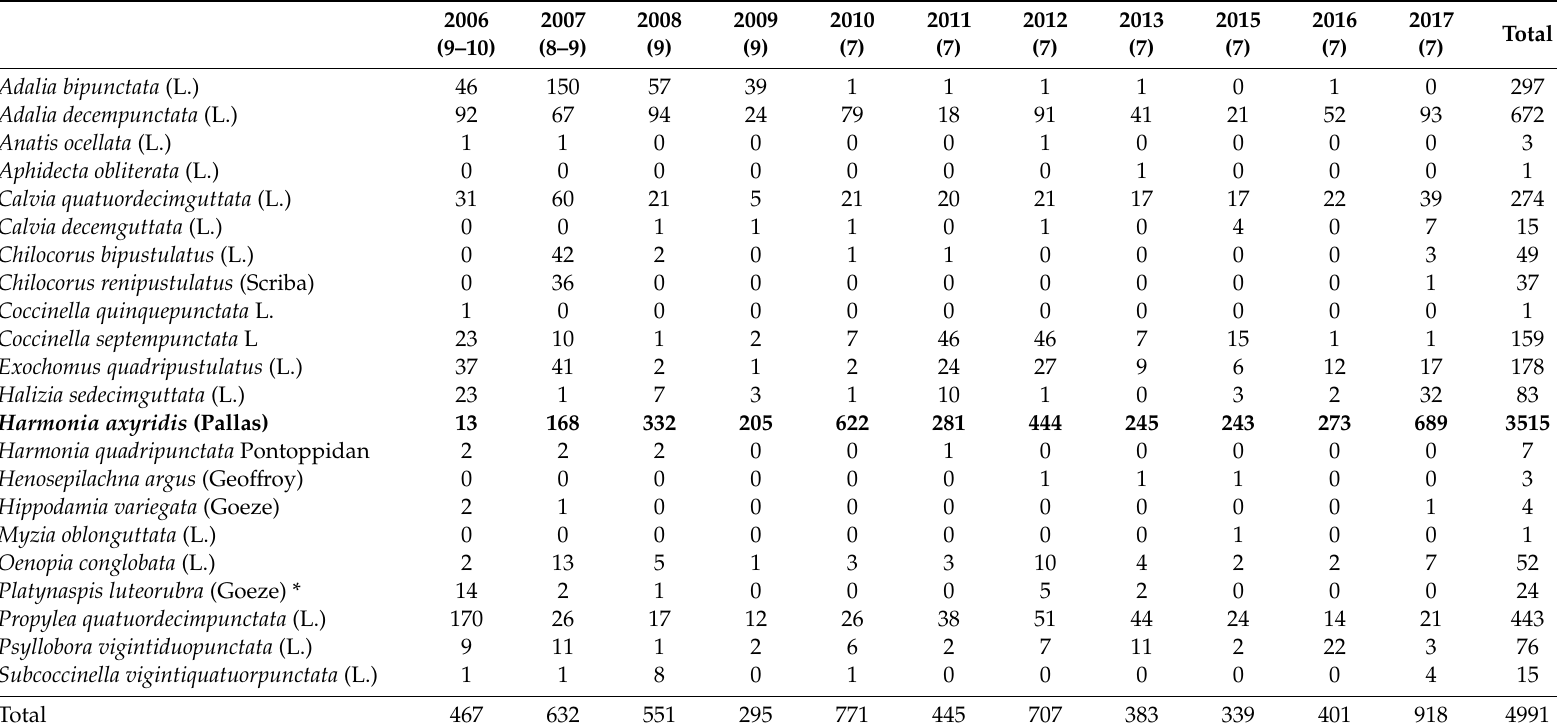
Table 1. Species and number of adult ladybirds collected at the 15 broadleaved hedges from 2006 to 2017. Numbers between parentheses indicate the number of collections. Ladybirds were not sampled in 2014.